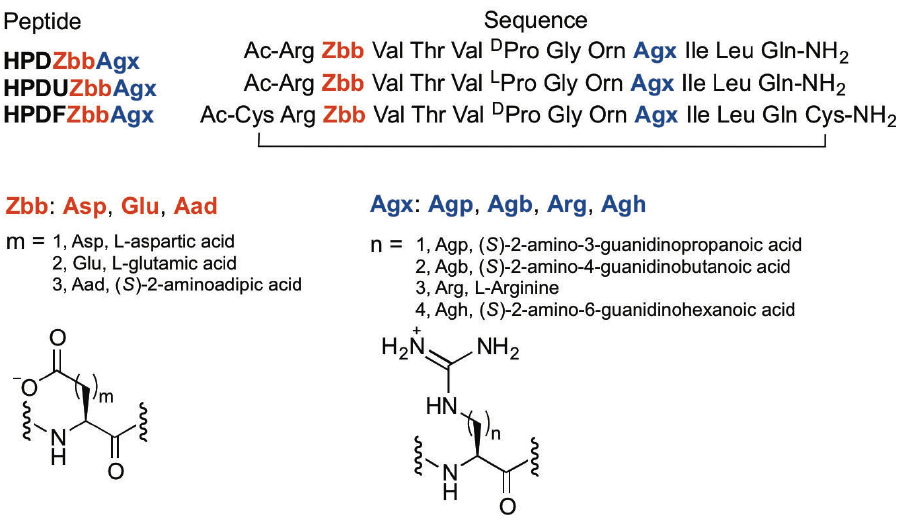
Figure 2. The sequences of the experimental HPDZbbAgx peptides, the fully unfolded reference HPDUZbbAgx peptides, and the fully folded reference HPDFZbbAgx peptides.